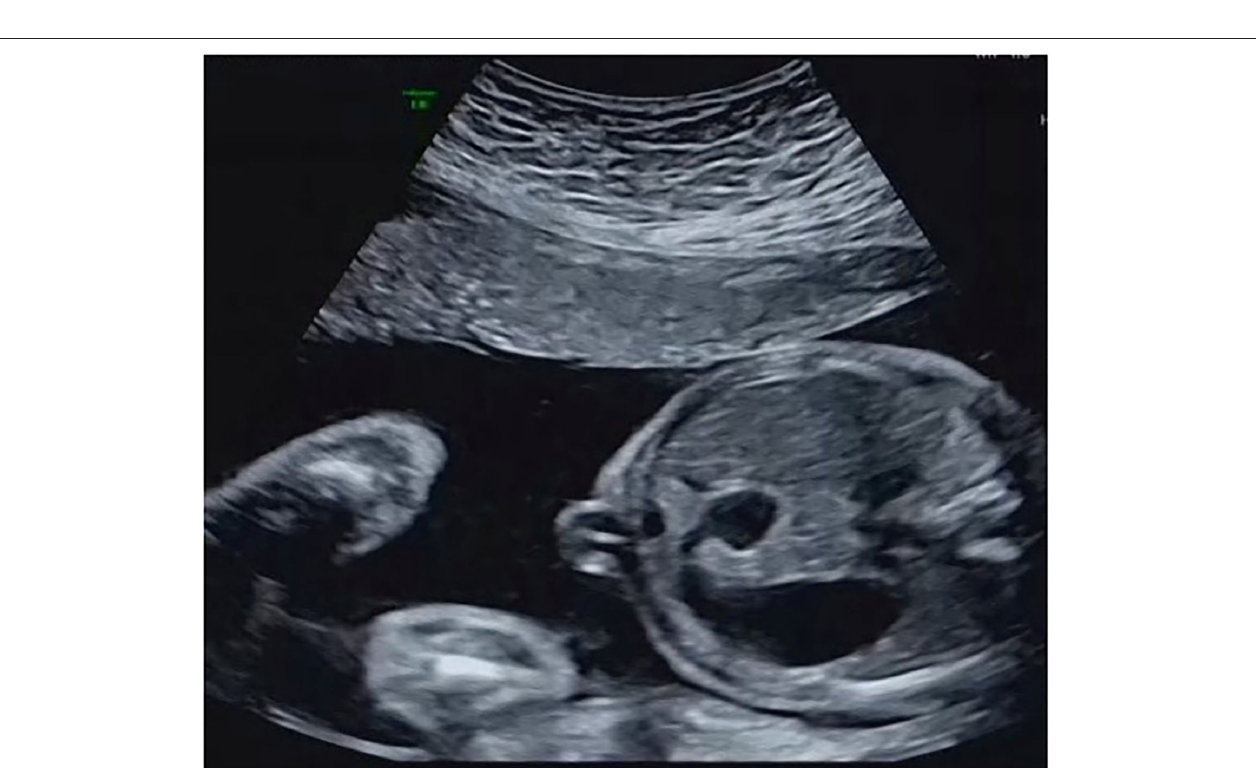
FIGURE 1 | The presence of the “double-bubble”